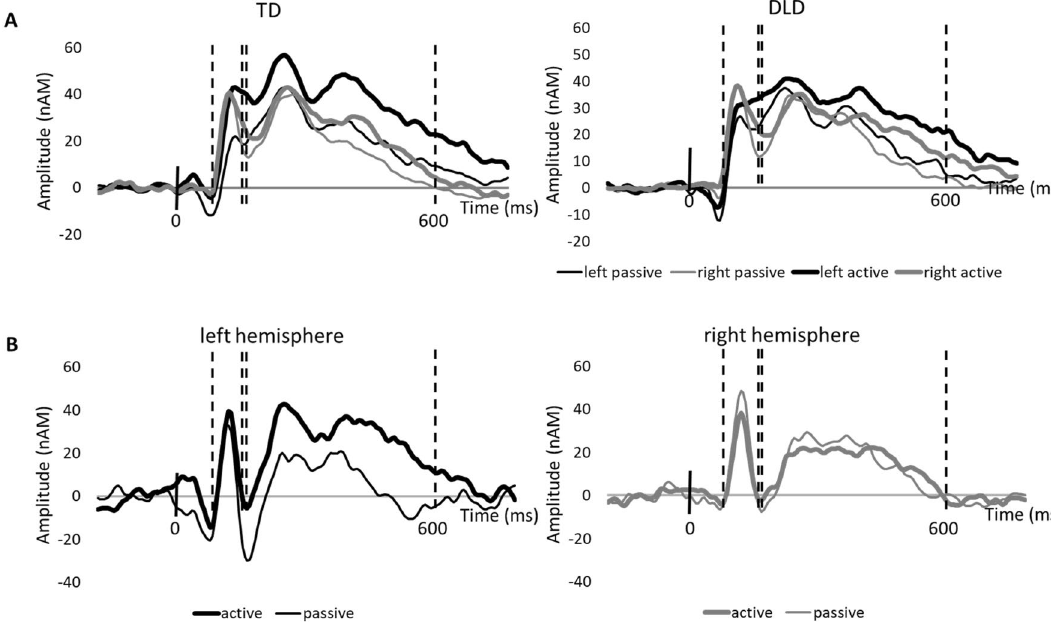
Figure 4. Time-course of activation of the dipolar sources. The early (90–180 ms) and late (185–600 ms) time windows are depicted with dashed vertical lines. ( A ) Grand-average waveforms of the ECDs located in the left (black lines) and right (gray lines) hemispheres separately for the TD and DLD groups. Responses to active and passive listening conditions averaged over the three sound types are plotted in thick and thin lines, respectively. ( B ) Average waveforms for active and passive listening in the left and right hemispheres of one TD